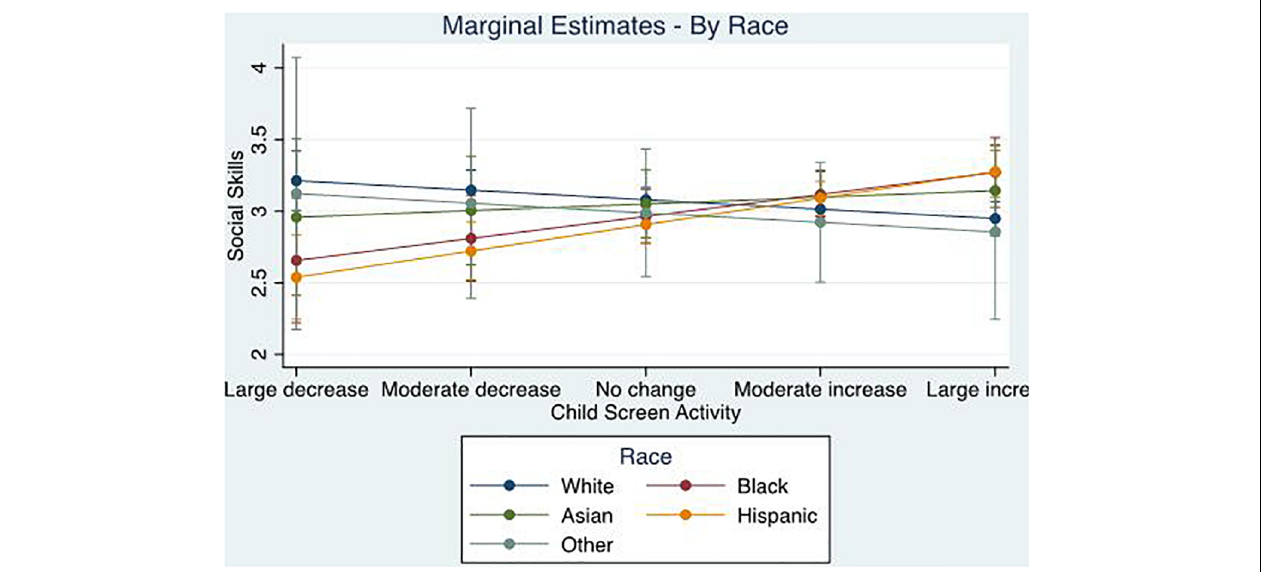
FIGURE 3 | Marginal estimates for change in social skills by race/ethnicity: change in screen